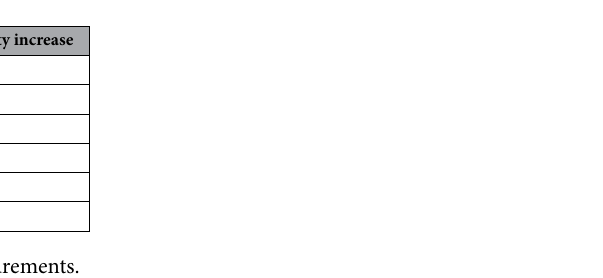
Fig. 1B,C,the imagery indicates are clear effect that the characters of the droplet content are strongly correlated to saliva fluid properties, and that the SCS leads to both fewer aerosols and larger droplets. The vertical intensity profile (column 4) indicates a downward skew and erratic fluctuations associated with the larger droplets. Next, consider comparisons to conventional mitigation methods of masks. Hence, the first comparison is with a sneeze that is covered with a mask where results are plotted in Fig. 1D. Comparison between Fig. 1A,D show the effectiveness of conventional droplet mitigation approaches. From this image, a clear result is the abil- ity for the mask to reduce the effective distance droplets and aerosols are dispersed. In general, there appears to be a reduction in droplets and an increase in aerosols from the mask. However, these aerosols travel a shorter